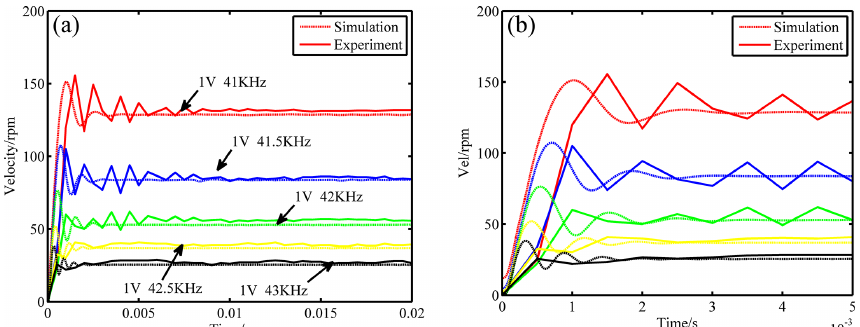
Figure 10. Comparison between simulation results and experimental ones when the amplitude is 1V: (a) the step response within 20ms; (b) the step response within 5ms.